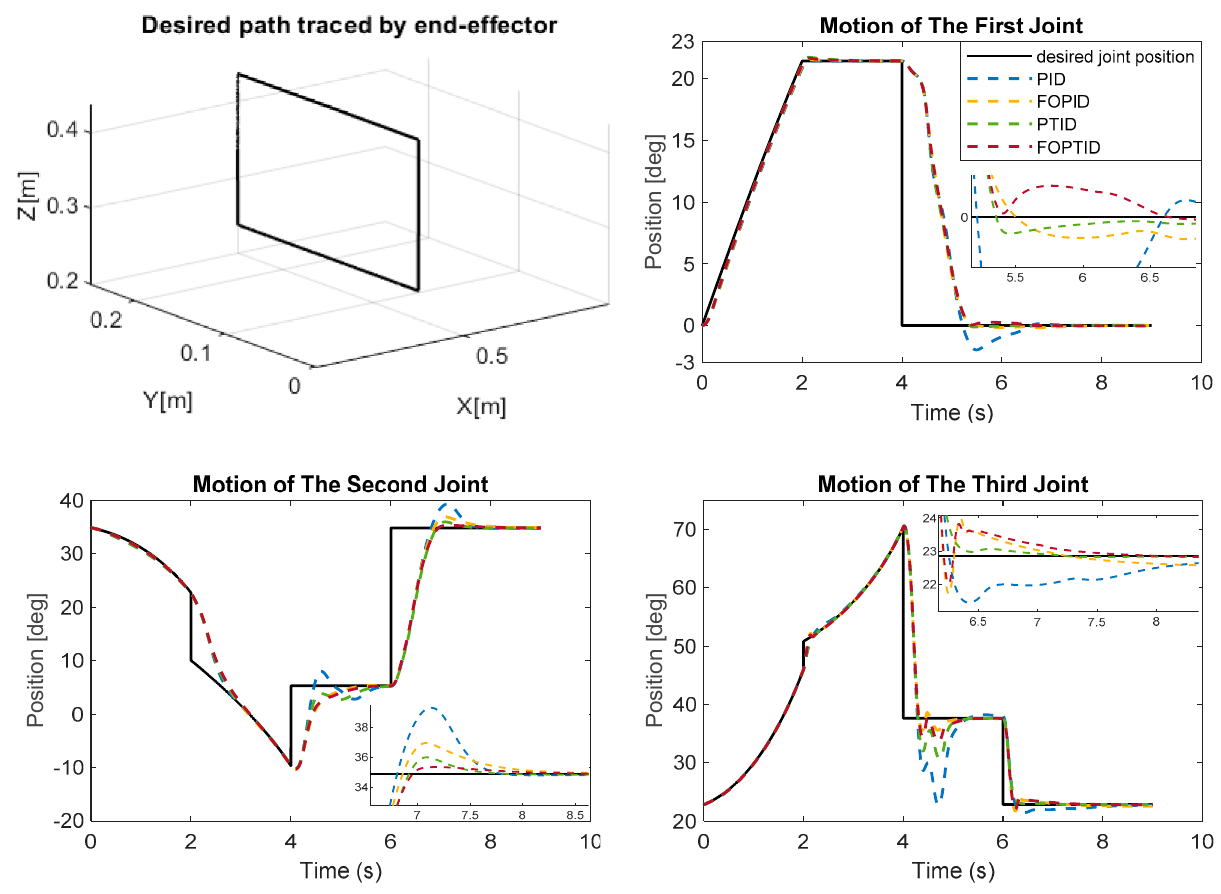
Figure 11. Trajectory tracking performance of PID, FOPID, PTID and FOPTID controllers for each joint.